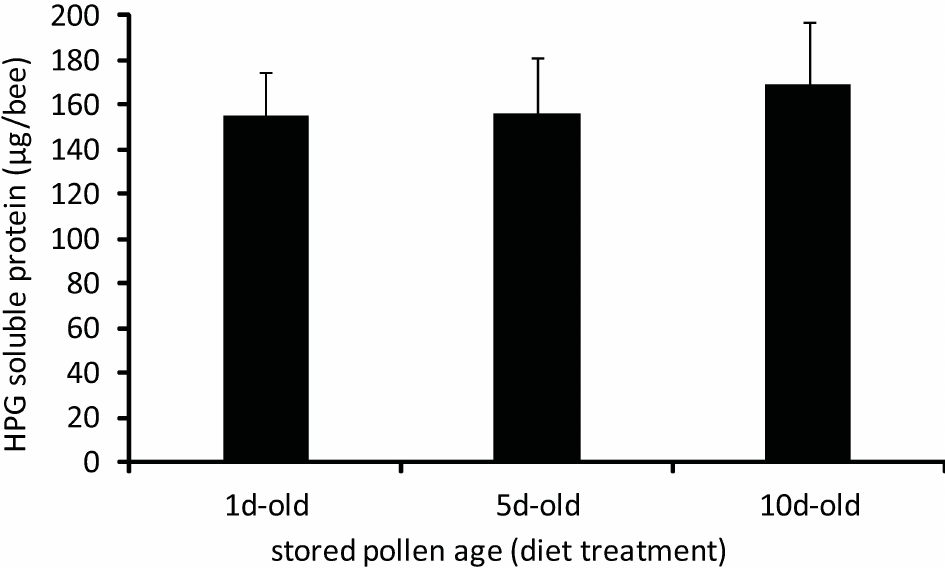
Fig 8. Total soluble protein contents of HPG from adult workers reared exclusively for 7d on 1d-old, 5d- old, or 10d-old stored pollen. Treatment means did not vary significantly by a one-wayANOVA. (p < 0.05; error bars are